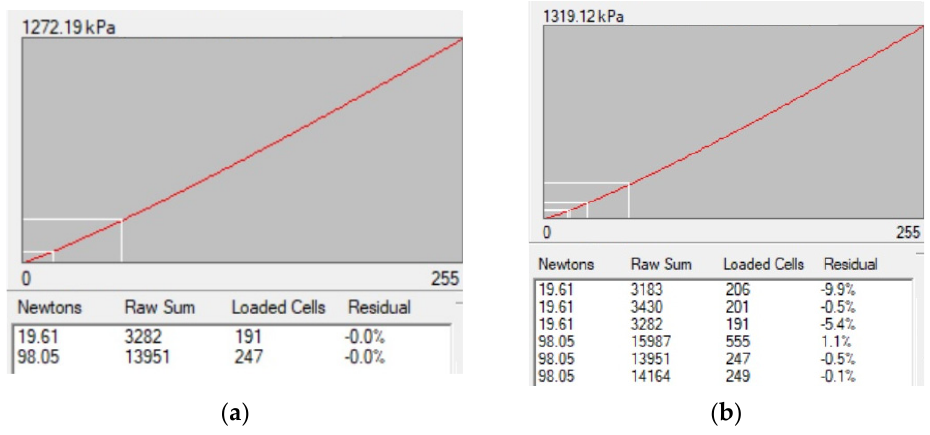
Figure 1. An example of tactile pressure sensor calibration in Tekscan’s I ‐ Scan software: ( a ) 2 ‐ points; ( b ) 6 ‐ points. The value provided above the plot of the calibration curve is calibrated saturation pressure of the sensor.